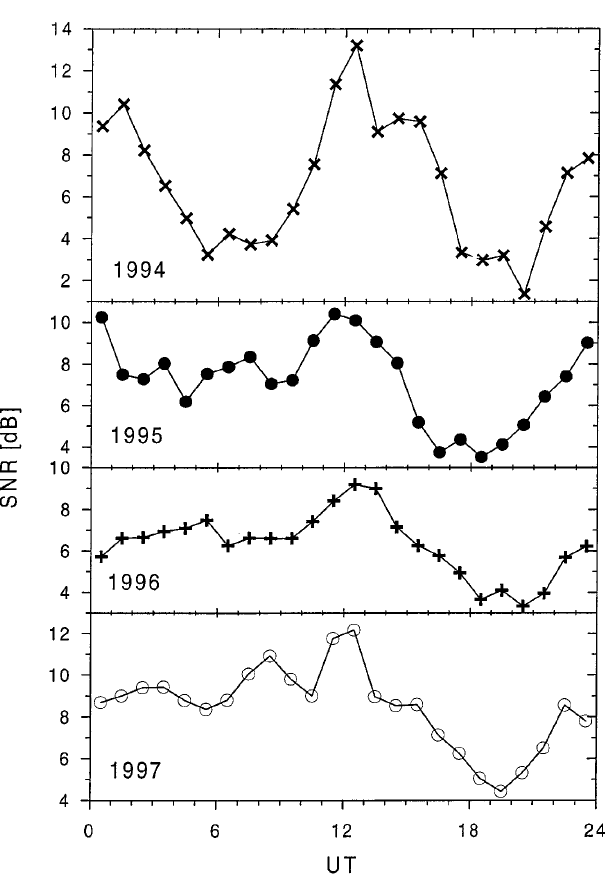
Fig. 9. Diurnal variation of SNR (83.0–87.5 km, Andenes) for the years 1994–1997 with data from June and